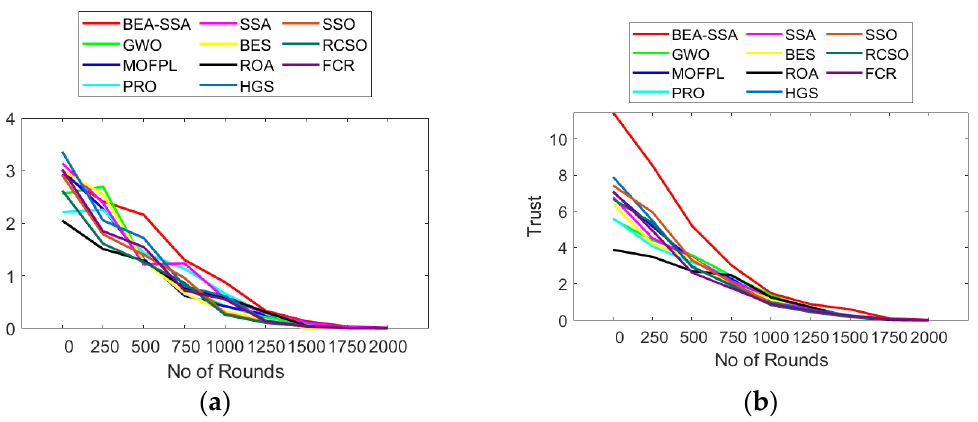
Figure 12. Trust analysis using BEA ‐ SSA over other conventional models [20–22,26] for node count of ( a ) 50 ( b ) 100.